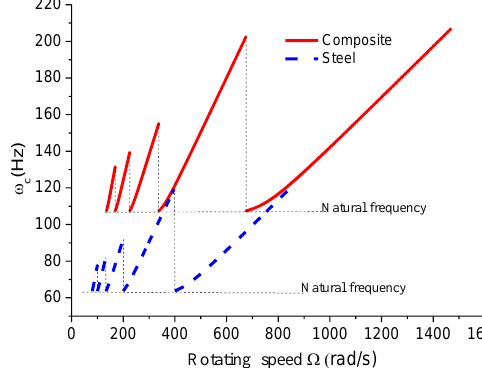
Figure 7. The variation of composite bar’s chatter frequency with the rotating speed.